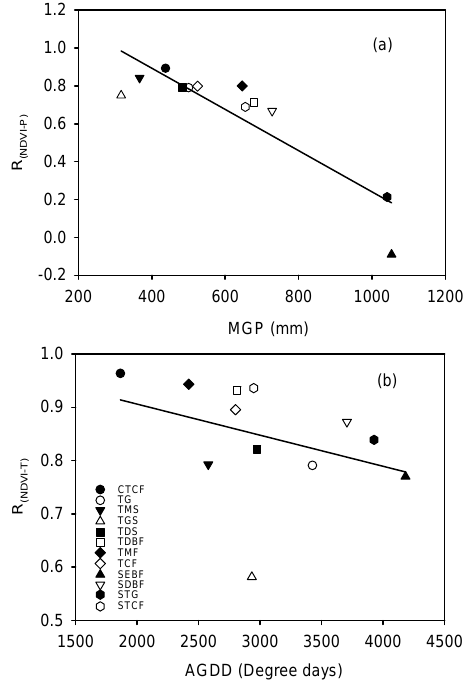
Fig. 4. (a) Relationship between mean growing season precipitation (MGP) and R ( NDVI-P ) (correlation coefficients between TI-NDVI g and MGP) ( R 2 = 0 . 78, P < 0.01). Data are spatial means by vegeta- tion type for the period 1982–2006. (b) Relationship between accu- mulated growing degree days (AGDD) and R ( NDVI-T ) (correlation coefficients between TI-NDVI g and AGDD) ( R 2 = 0 . 13, P =0.19). Data are spatial means by vegetation type for the period 1982–2006.